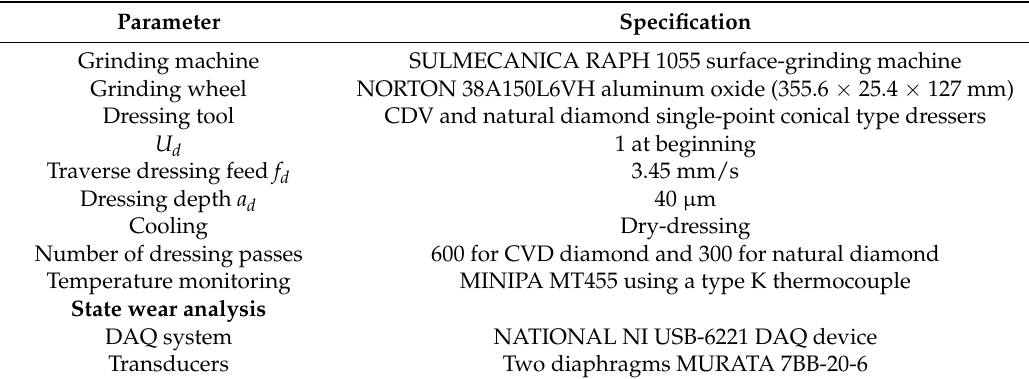
Table 1. Experimental test